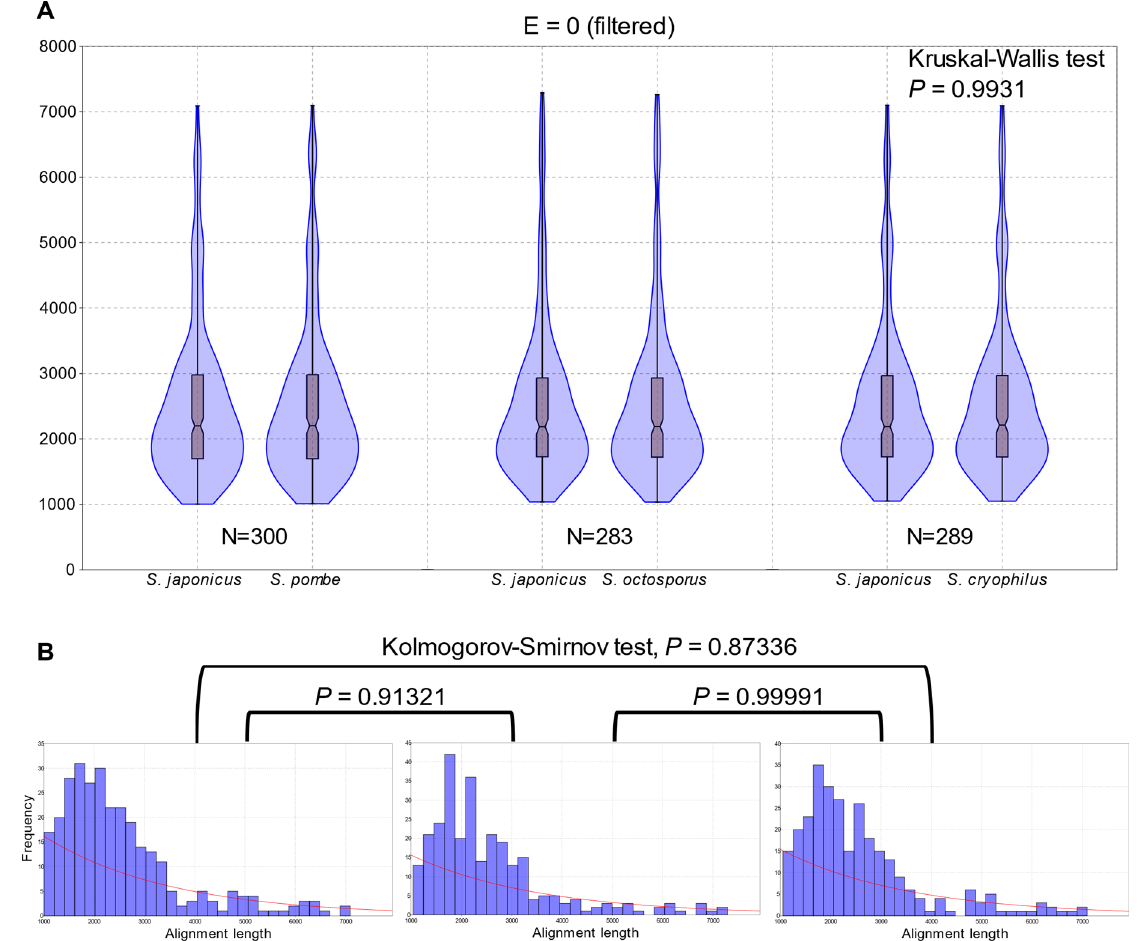
Figure 2. Conserved regions of the genomes show equal distributions. ( A ) Length distribution of the pairwise whole genome alignments created with YASS ( E = 0). Violin plots show kernel density for the samples. Box plots indicate the 25–75 percent quartiles. Horizontal lines within the boxes show the medians of the samples, notches indicate the 95 percent confidence intervals for the medians. Minimal and maximal values are depicted by the whiskers. N: sample size. Y -axis shows the lengths (in nucleotides) of the individual alignments. There was no significant difference in the variance of the data. ( B ) Histograms depicting the most conserved genomic regions of S. japonicus in different pairwise scenarios and their divergences from the concerning exponential distributions. Bin = 30. The distributions of the pairwise cases were not significantly